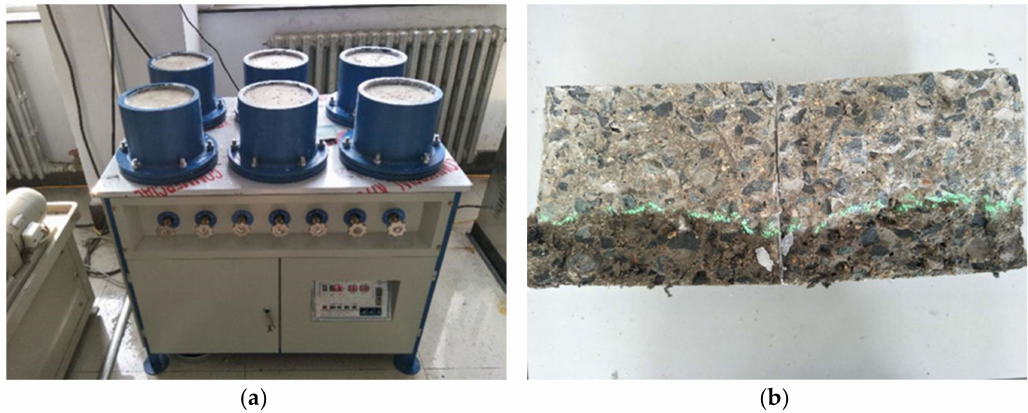
Figure 7. Concrete penetrometer and split specimen after the impermeability test. ( a ) Concrete penetrometer; ( b ) split specimen after the impermeability